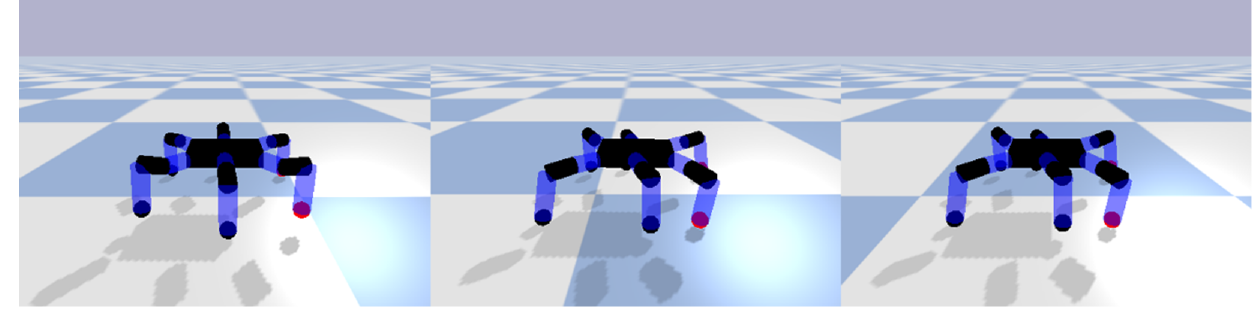
Figure 4. Hexapod robot walks with a tripod gait generated by the CPG algorithm.